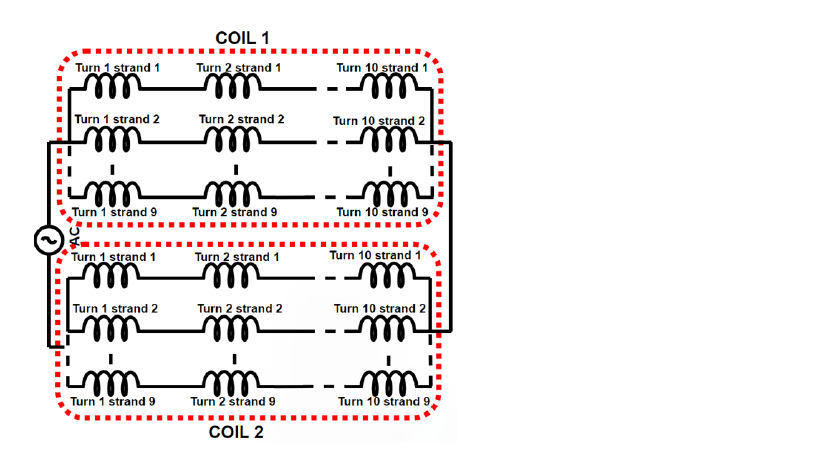
Figure 2. Representation of circuital connections of strands and turns in the motorette model.